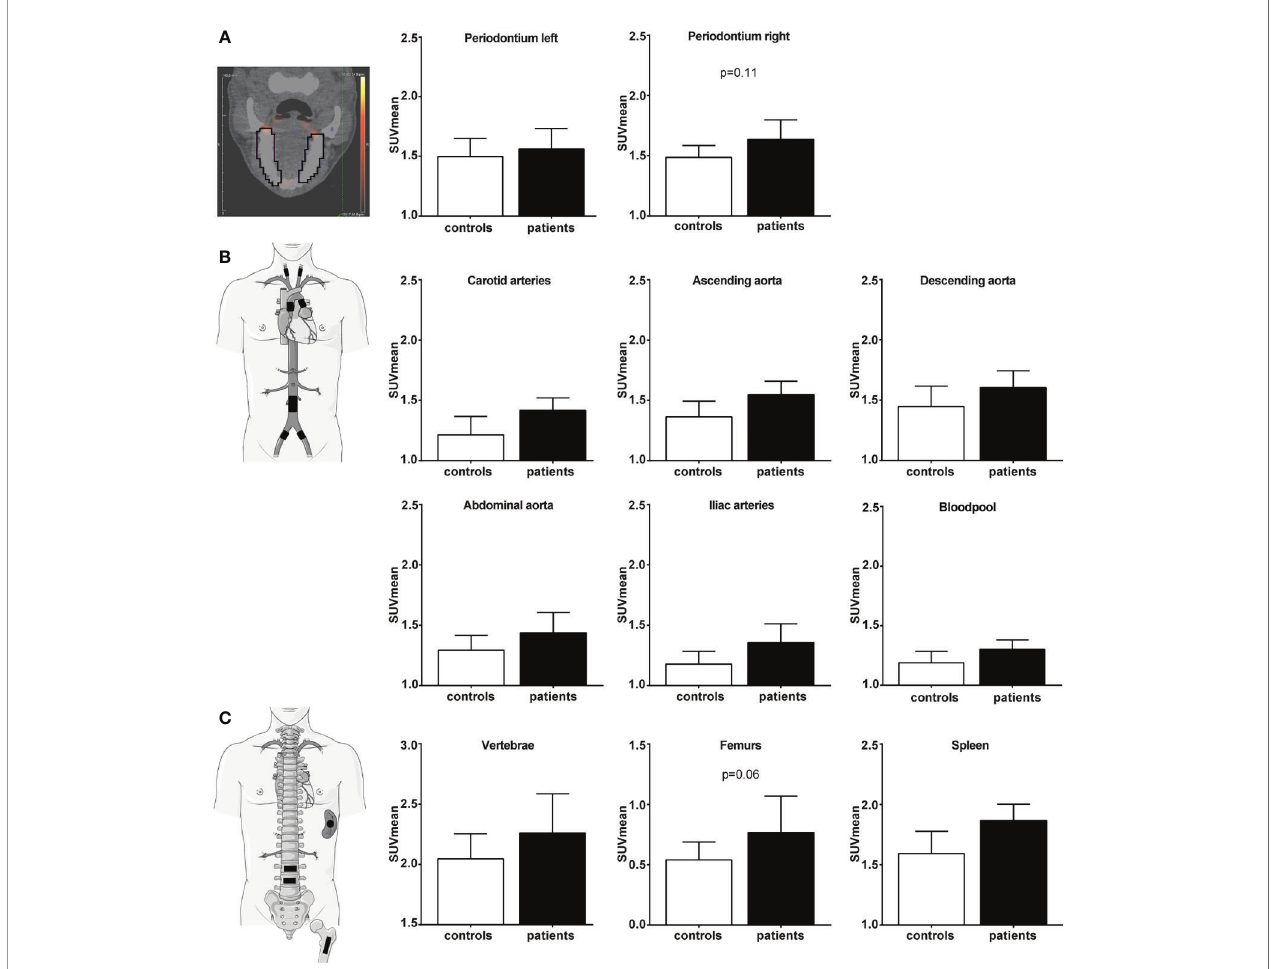
FIGURE 4 | Periodontal, vascular wall in fl ammation and hematopoietic tissue activation on [ 18 F]FDG PET/CT scan. Standard uptake value (SUV) of each region in control participants (white bars, n=14) and participants with periodontitis (black bars, n=14). Regions of interest are illustrated in the fi gure with black